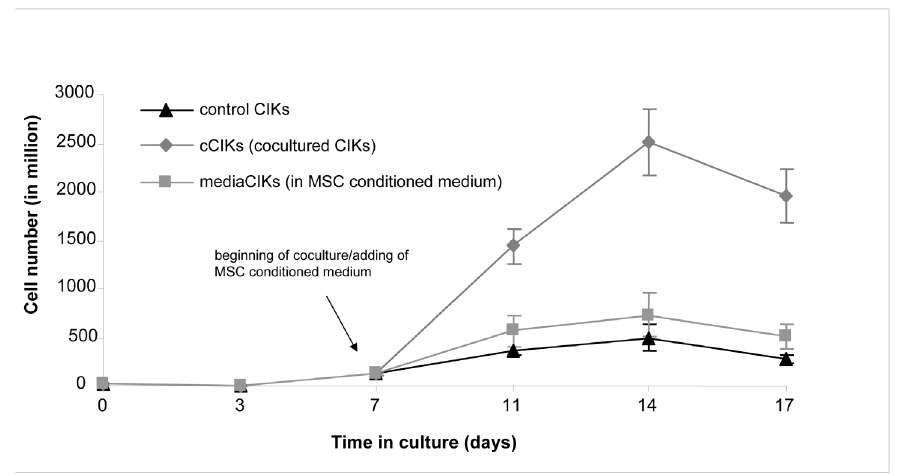
Figure 1. Comparison of cytokine-induced killer cell (CIK) proliferation. CIKs were cultivated according to protocol (controls). On day 7, some of the CIKs were cultivated either with mesenchymal stem cells (cCIKs) or in MSC-conditioned medium (mediaCIKs), and proliferation was compared with that of controls. After starting the coculture, cCIKs proliferated faster than controls (p , 0.05). The mediaCIKs displayed increased proliferation (p . 0.1), too, but proliferation rates did not reach the level of cCIK proliferation.